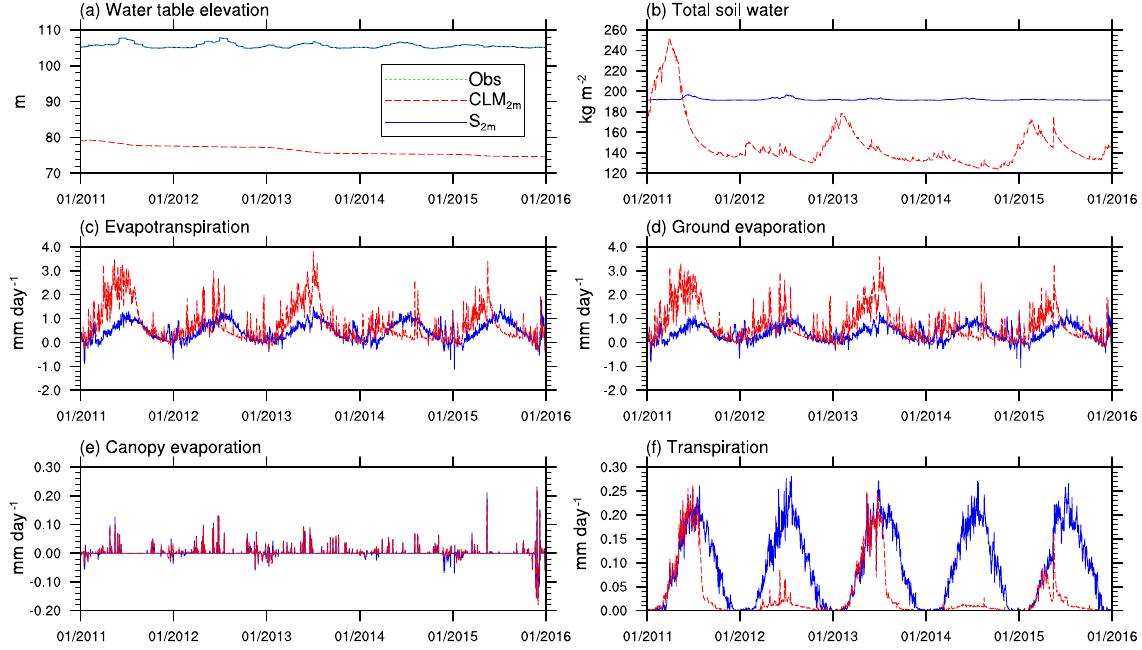
Figure 12. Comparison of key hydrologic fluxes and state variables simulated by CLM 2m and S 2m .